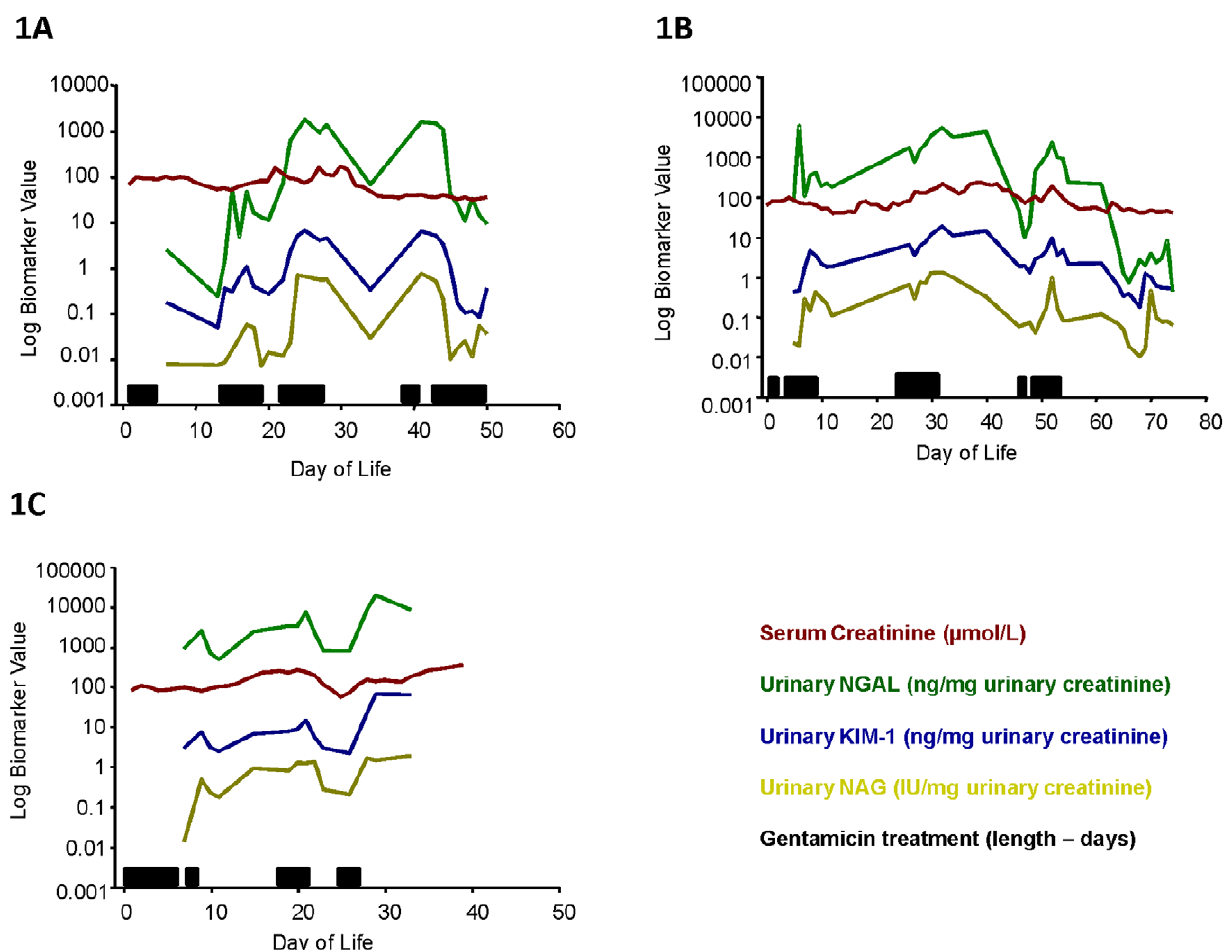
Figure 1. Longitudinal biomarker analysis of infants treated with multiple courses of gentamicin with a change in serum creatinine concentration (AKI). Representative figures demonstrating the longitudinal quantification of the biomarkers KIM-1 (blue; ng/mg. uCr), NGAL (green; ng/mg. uCr), NAG (yellow; IU/mg. uCr) and serum creatinine (red; m mol/L) for three infants treated with gentamicin (A–C). Gentamicin treatment episode and length of treatment (days) are indicated by the black horizontal bar on each figure for that individual patient.